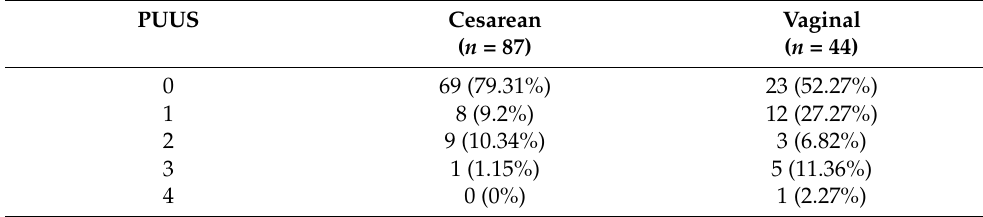
Table 4. Proportion and number of patients for each PUUS value regarding the method of delivery.